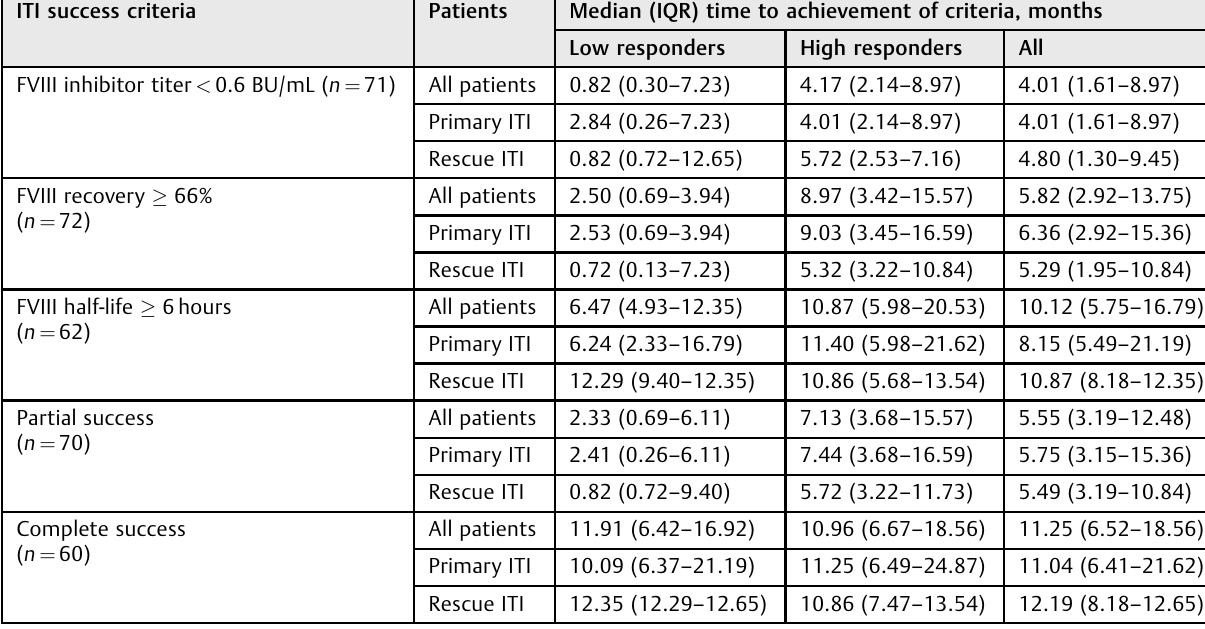
Table 2 Time-to-achievement of ITI success according to responder type and prior ITI ITI success criteria